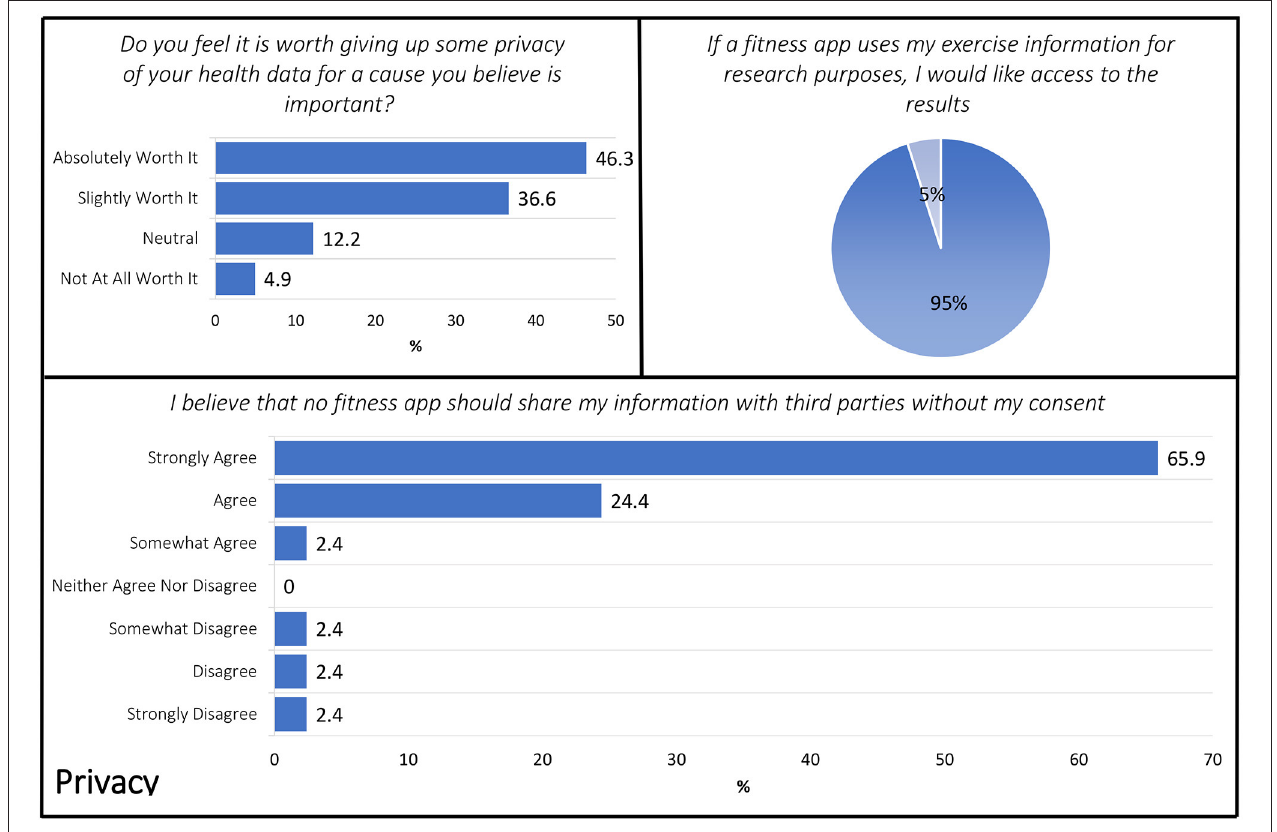
FIGURE 3 | Exit Survey items that aligned with the Privacy